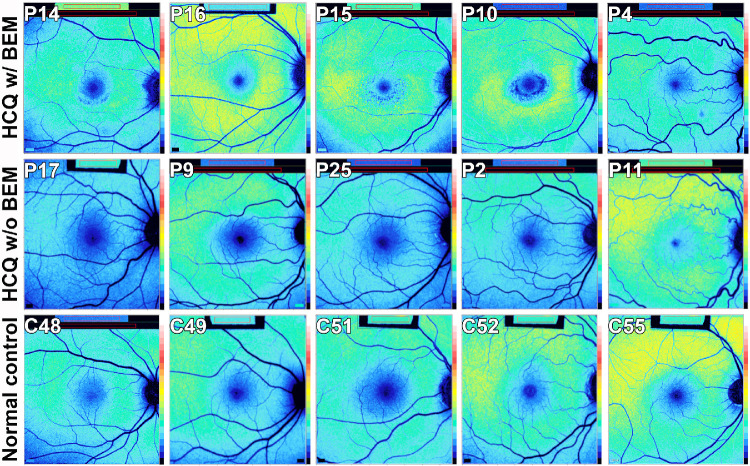
Color-coded qAF images. C, control subject; P, patient. Top row: Images acquired from HCQ-treated patients presenting with BEM based on SD-OCT findings. In P10 and P15, note the change in the SW-AF distribution with a higher intensity in the inferior, nasal, and temporal retina than superior retina, as compared to the normal controls (bottom row). Mottling is also visible in P10, P15, and perhaps P14. Second row: Images from eyes of patients on high-dose HCQ (>1000 g; P17, P25, P2, and P11) and low-dose HCQ (<1000 g, P9). The AF signal appears to have a distribution similar to the control subjects. Bottom row: Age-matched healthy eye control. The numbers following the letter C indicate the age of each control subject. The rectangles at the top of the images reflect the internal fluorescent reference used to normalize the intensities. Left eyes are represented as right eyes for P9, P25, and C49.